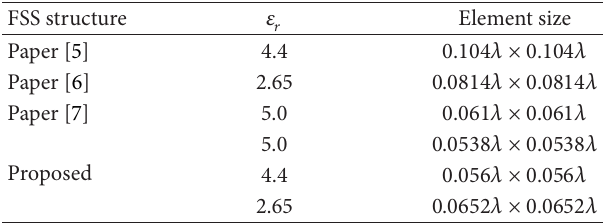
Figure 7: Simulation model of designed FSS. Table 2: Comparisons of the element sizes for the four FSSs.